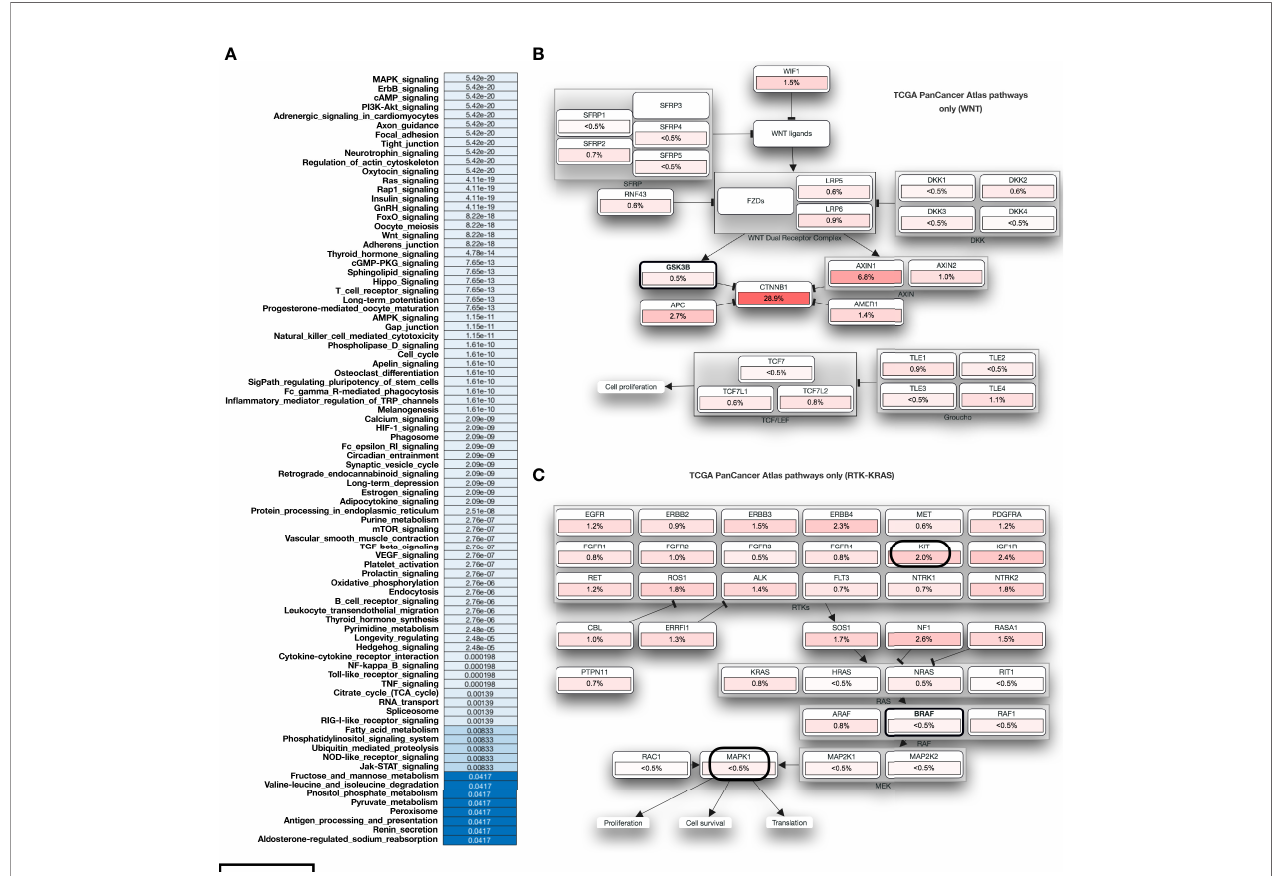
FIGURE 6 | Functional impact of mutation in case of HCC. (A) Overall enriched pathways with their respective p-values in the case of HCC. (B, C) represents those mutated genes and belongs to the TCGA PanCancer Atlas pathways acting as major role players.